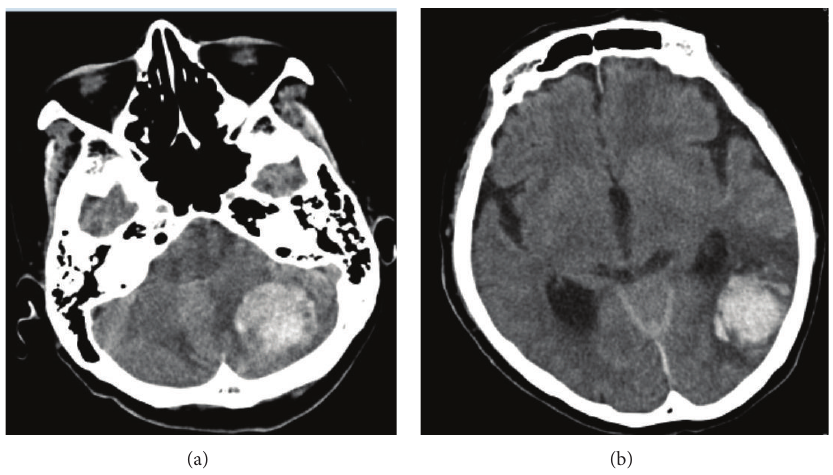
Figure 3: Hemorrhage was observed in both the left cerebellum (a) and the temporal lobe (b) 5 days after spine surgery on CT.